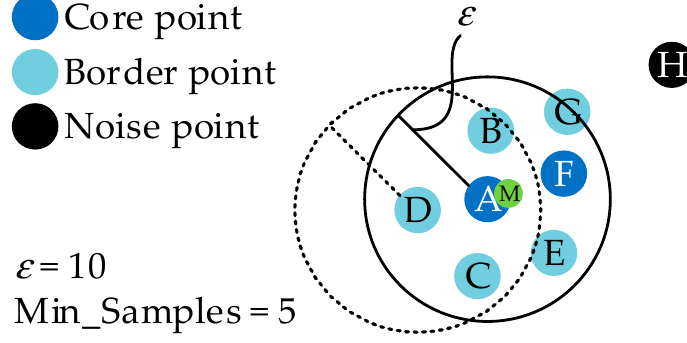
Figure 2. Example of DBSCAN (density-based spatial clustering of applications with noise).